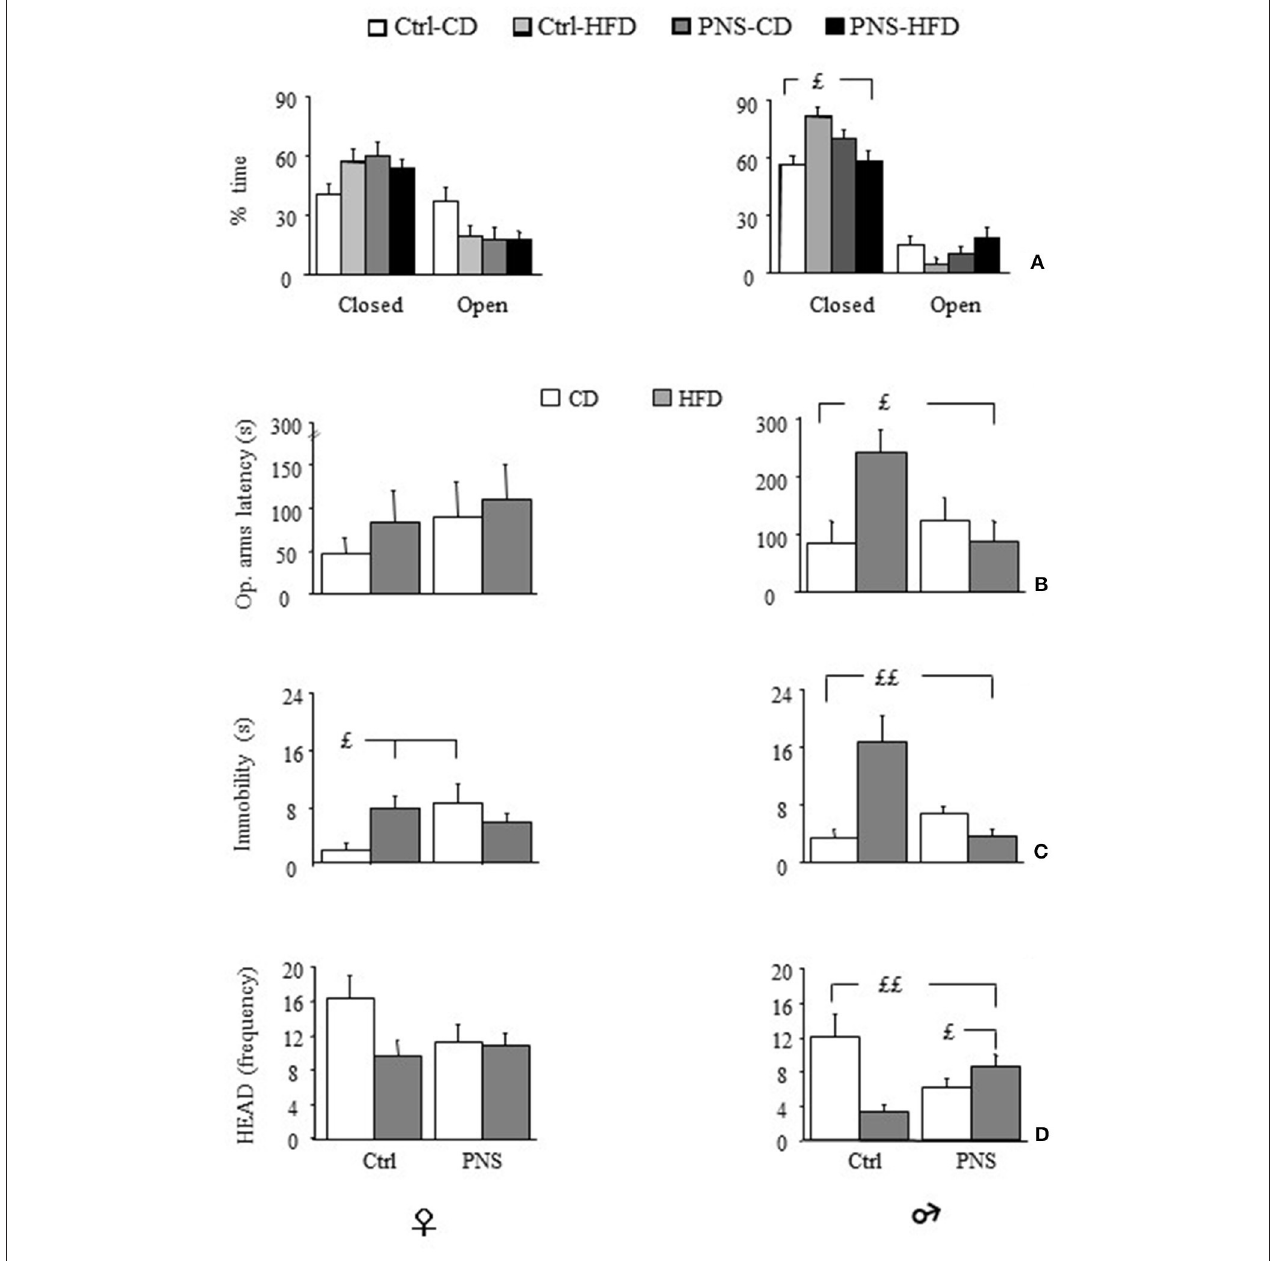
FIGURE 5 | Anxiety-like behavior in the Elevated Plus Maze (EPM). (A) Time (%) spent in closed vs. open arms: HFD feeding increases anxiety levels in male subjects however, PNS buffers this effect reducing the time spent in the closed arms of the maze (Ctrl-HFD vs. Ctrl-CD and PNS-HFD); (B) Latency to enter the open arms is increased by HFD only in males though PNS is able to prevent this increase (Ctrl-HFD vs. Ctrl-CD and PNS-HFD); (C) In male subjects, immobility is specifically increased by HFD though PNS is able to prevent this increase (Ctrl-HFD vs. Ctrl-CD and PNS-HFD); by contrast, in females both HFD and PNS increase the time spent immobile (Ctrl-HFD and PNS-CD vs. Ctrl-CD). (D) Head dipping (HEAD), a measure of exploration, is decreased by both HFD and prenatal stress only in males. Exposure to the double hit (PNS-HFD) prevents this decrease (Ctrl-HFD and PNS-HFD vs. Ctrl-CD and PNS-CD vs. Ctrl-CD). Data are presented as means + SEM. £ p < 0.05; ££ p < 0.01, interaction between Prenatal Condition and Diet.